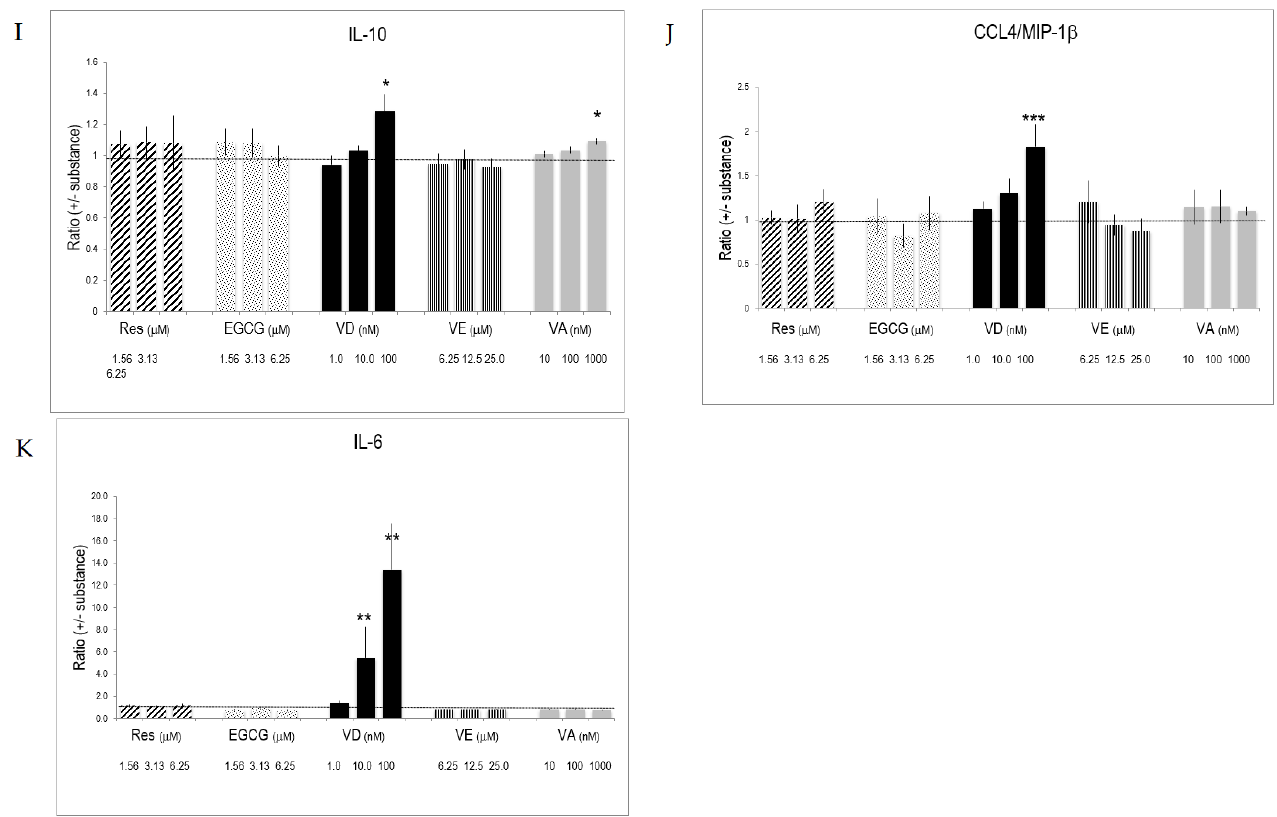
Figure 2. Cytokines and interleukins produced by activated T lymphocytes and the impact of substances on their production. CD3 + cells were stimulated for 5 days with anti-CD3/CD28 in the presence of various concentrations of substances. Cytokines, interleukins, and chemokines secreted by triplicate cultures were determined by multiplex ELISA. The data were normalized against values obtained from vehicle-treated cultures. Bars indicate SD (N = 3). * = p < 0.05; ** = p < 0.01; *** = p < 0.001. ( A – K ) refers to measured secretion of IL-2, TNF- α , INF- γ , CXCL8/IL-8, IL-5, CXCL10/IP-10, IL-13, CCL5/RANTES, IL-10, CCL4/MIP-1 and IL-6, respectively. The dotted line in the graphs indicates the level of the reference ratio (=1). Table 1. Effect of substances on the T h 1/T h 2 ratio.